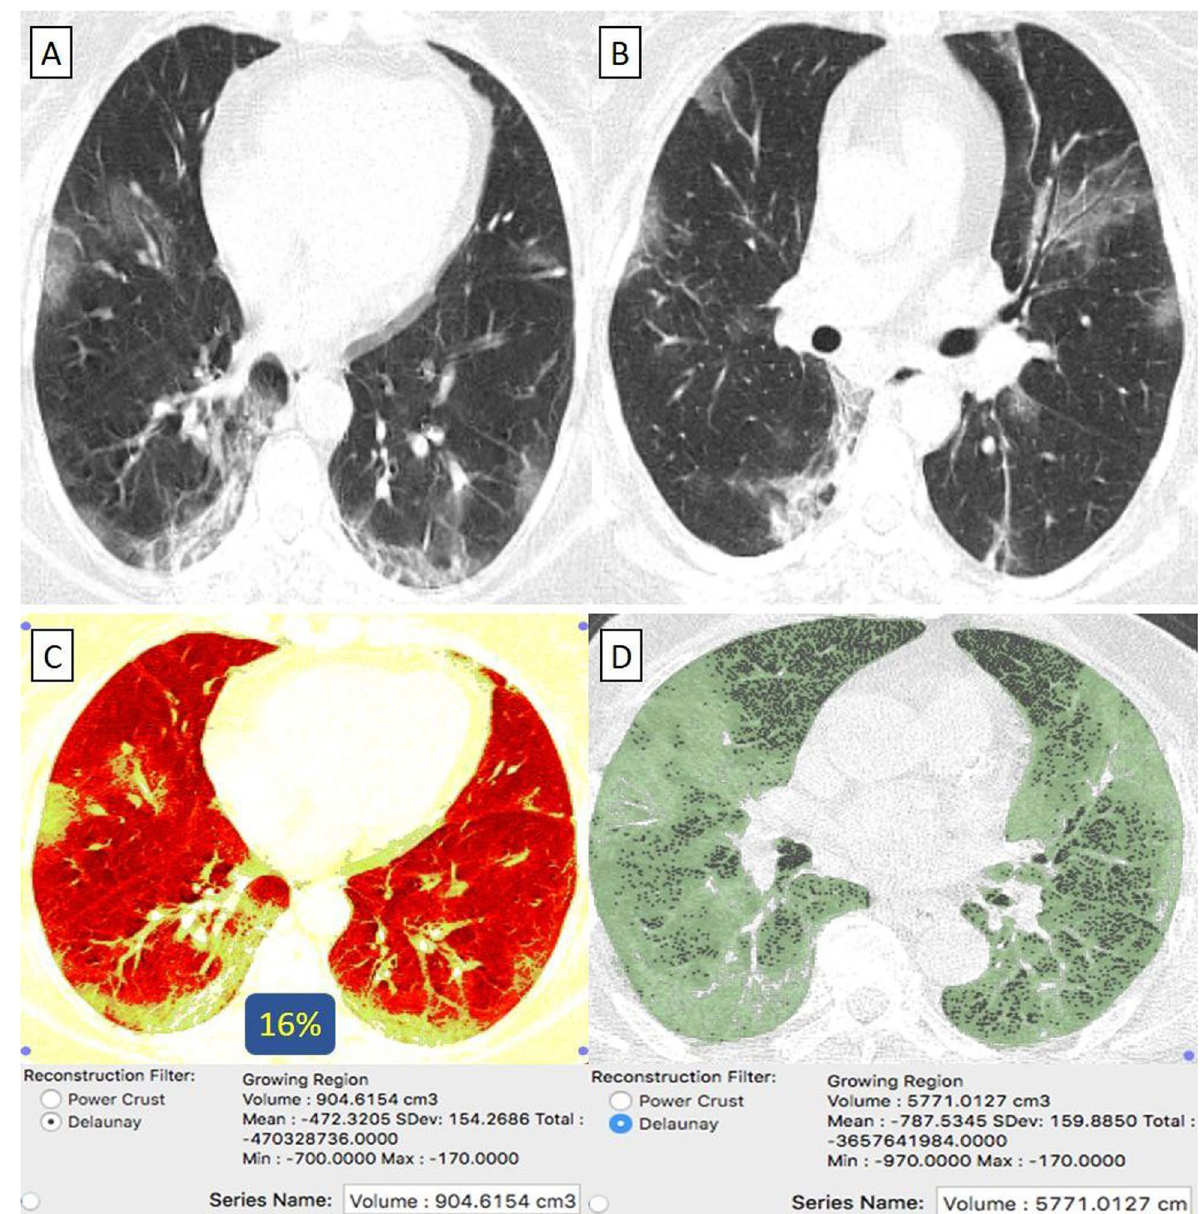
Fig. 4 A 43‑year‑old female patient with negative past medical history and had received “Oxford‑AstraZeneca” vaccine then got COVID‑19 infection. A , B Axial chest CT cuts (lung window) showed bilateral mainly peripheral located ground‑glass pneumonic patches and fine atelectatic